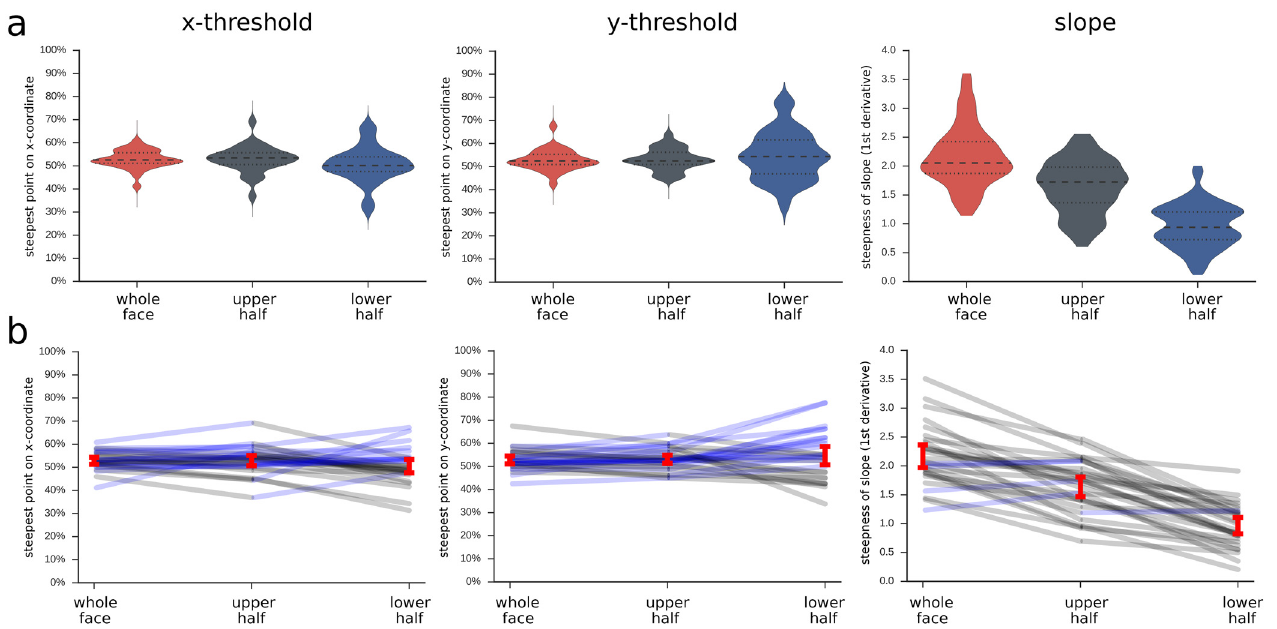
Fig 4. Parameters of logistic function for different masking conditions. a, violin plots with width indicating density of values, inner lines indicating median and 25% and 75% quartiles; b, red bars indicate 95% confidence intervals of the mean for each condition; line graphs in the background depict the raw data of each participant; black lines indicate that the participant's value for the left-hand condition is numerically bigger than the right-hand value; blue line indicates that the value is smaller for the left-hand compared to right-hand condition; 'whole face', whole face is visible (no masking); 'upper half', upper face half is visible (lower half is masked); 'lower half', lower face half is visible (upper half is